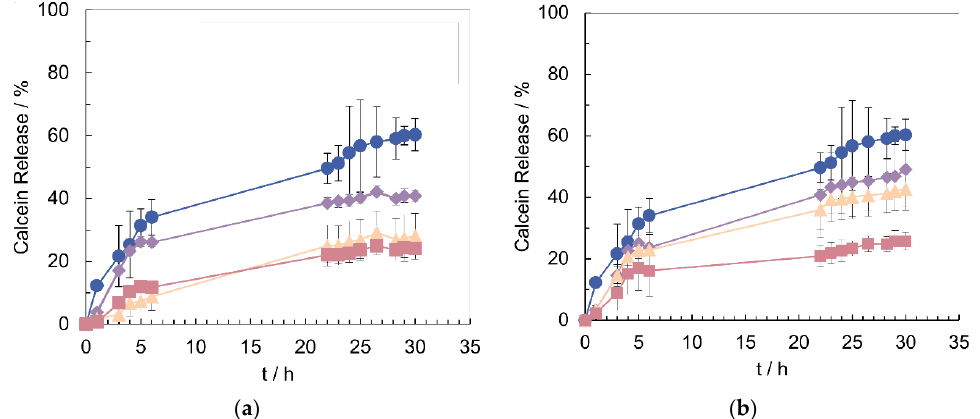
Figure 3. Calcein release profiles at 37 °C and pH = 7. Blue circles: LIP; purple diamonds: 2.5% of copolymer; orange triangles: 5% of copolymer; pink squares: 10% of copolymer. ( a ) PLU-PD PLCs. ( b ) PLU-PAA PLCs. Results are expressed as mean ± standard deviation (SD), n = 3. Calcein release was also determined at different pHs (from 2 to 11, at 37 °C) and dif- ferent temperatures (37 and 42 °C, at pH 7), as shown in Figures 4 and 5a, respectively. When slight changes in pH were applied (either higher or lower then 7.0), PLCs became significantly less stable (Figure 4). As expected, the same outcome was not observed in LIPs (Figure 4). Among the copolymers, the pH destabilization is more evident with PLU- PAA PLCs (i.e., 10% PLCs, Figure 4). On the other hand, PLU-PD PLCs exhibit a faster and higher calcein release at 42 °C (ca. 22%) for the same incubation time (Figure 5a).